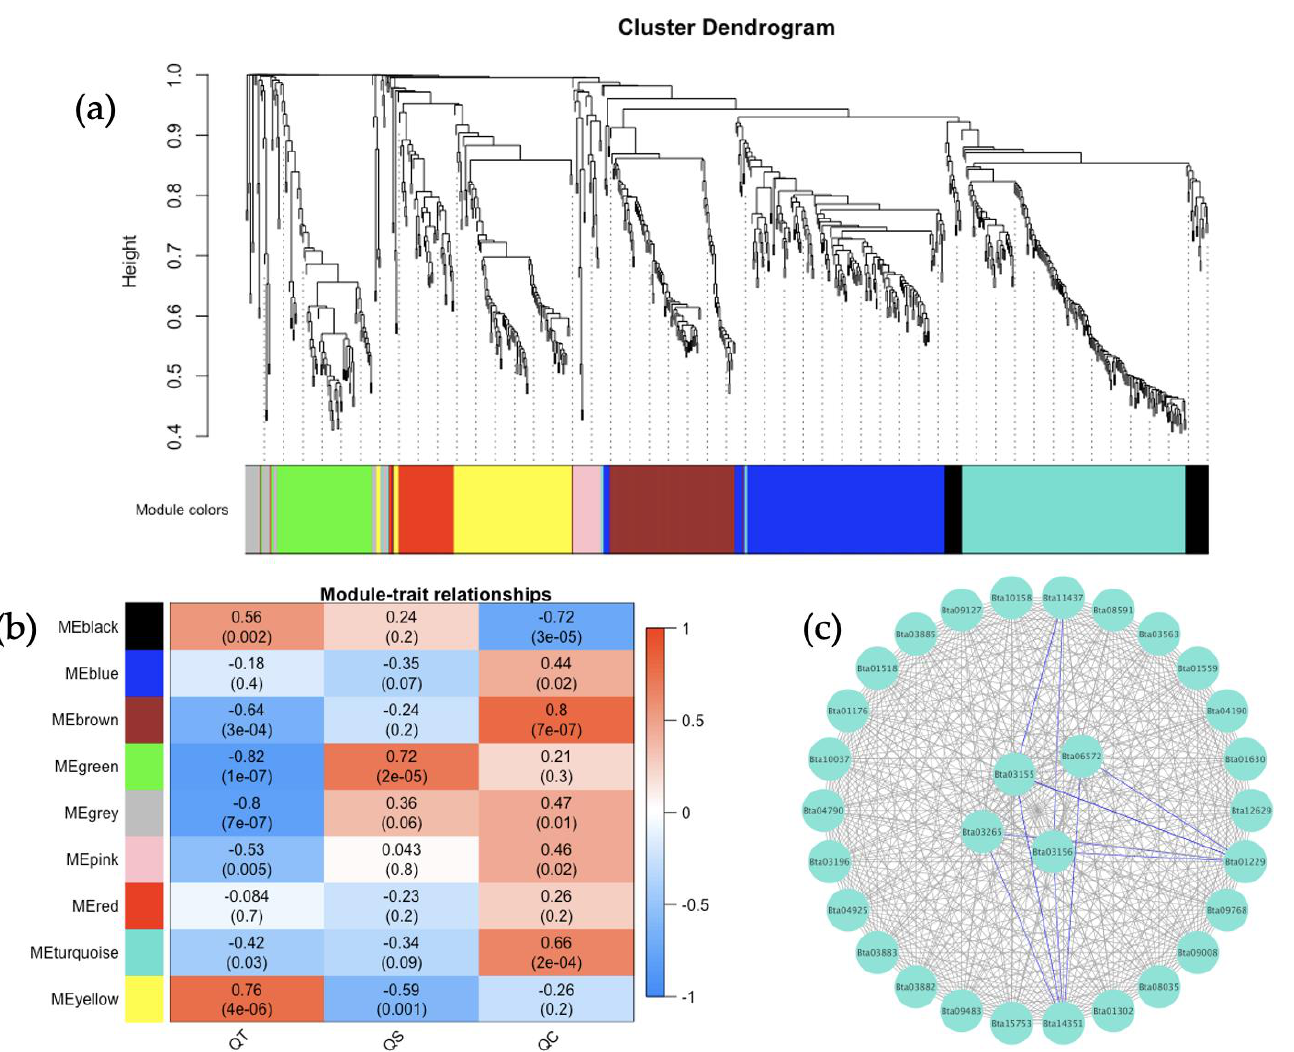
Figure 6. Bemisia tabaci Middle East-Asia Minor 1 (MEAM1) adults weighted gene co-expression network analysis. ( a ) Dendrogram clustering showing eight modules of co-expressed genes. A total of 784 genes are represented in this network, with 454 genes belonging to MEturquoise. ( b ) Heatmap showing the correlation of module eigengenes in relation to B . tabaci MEAM1 that acquired TYLCV (BT), SiGMV (BS), or CuLCrV (BC). ( c ) Top 30 genes from MEturquoise with connectivity lines (blue) associated with the top 5% of the connected genes.